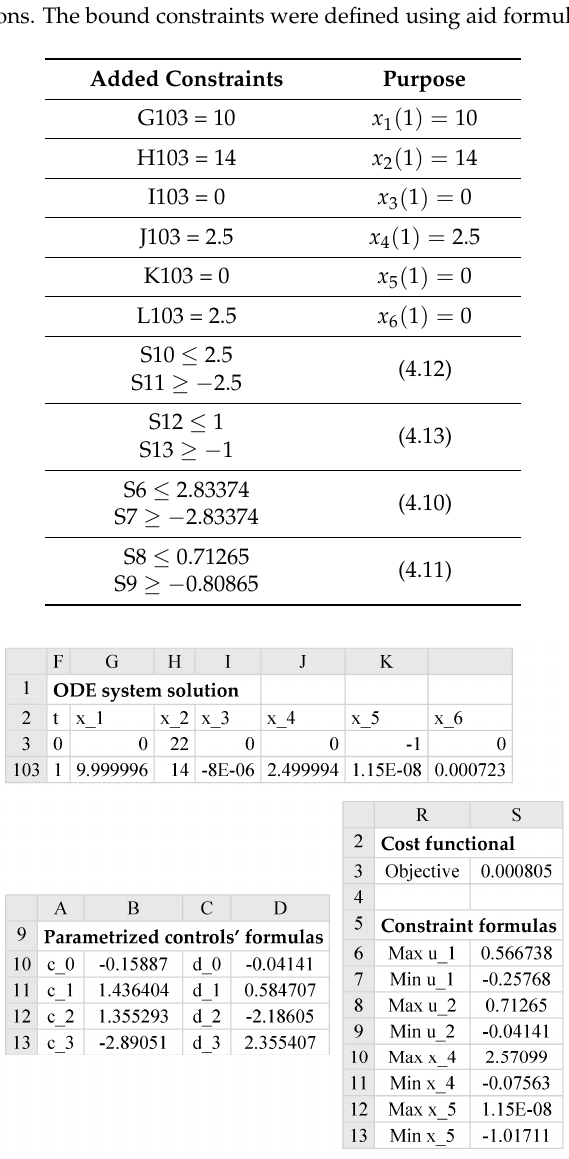
Figure 17. Best-found solution obtained by Excel’s Solver for optimal control problem (17)–(29). Table 4. List of constraints added to the NLP Solver for optimal control problem (17)–(29) and their corresponding equations. The bound constraints were defined using aid formulas listed in Table 3.